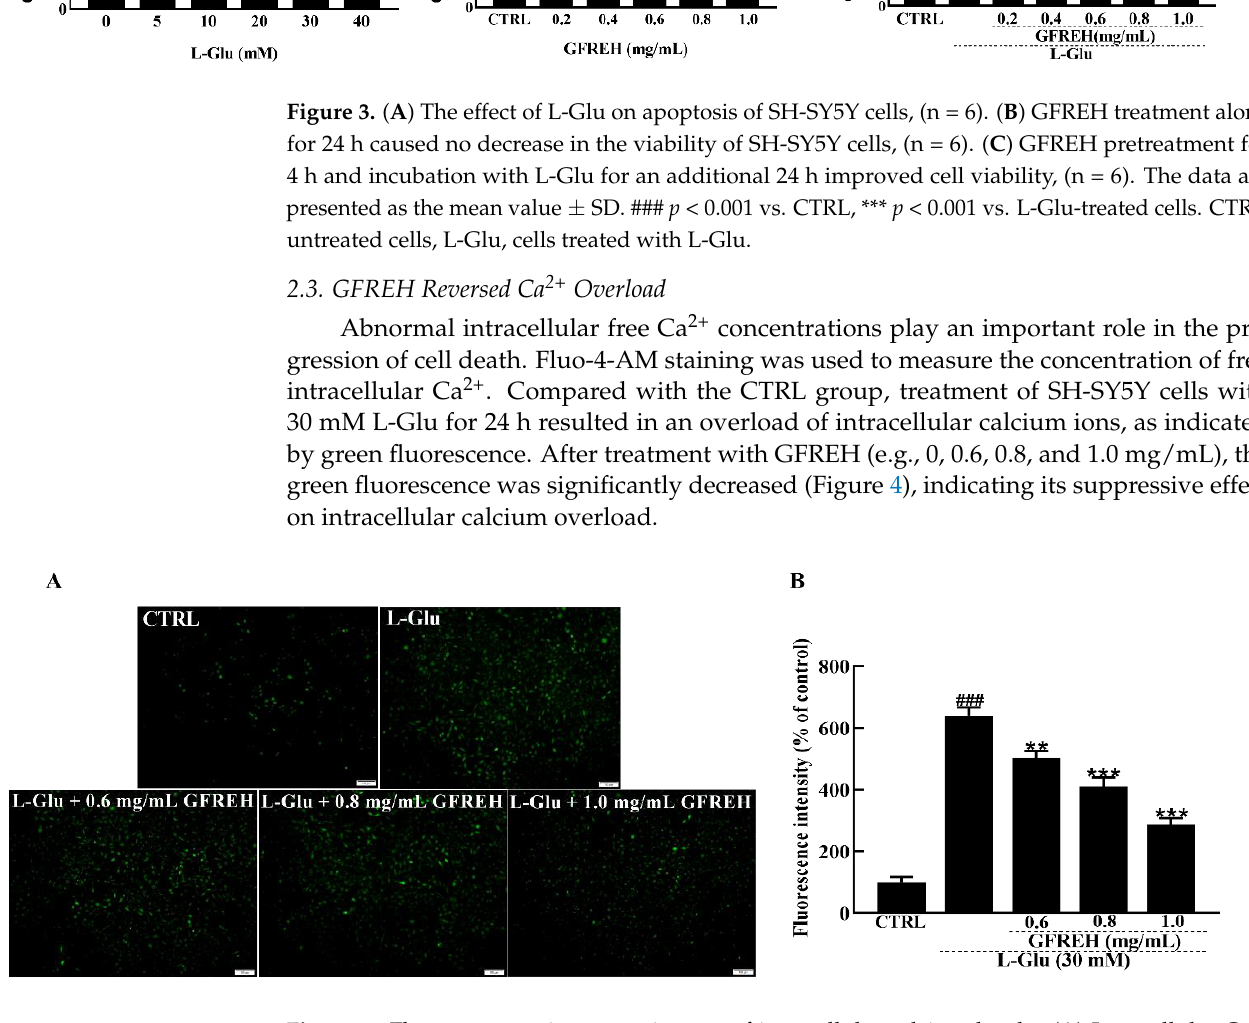
Figure 4. Fluorescence microscopy images of intracellular calcium levels. ( A ) Intracellular Ca 2+ overload caused by L-Glu was reversed by GFREH pretreatment, as detected by Fluo-4-AM stain- ing. The scale bar is 100 μm. ( B ) Fluorescence quantification by ImageJ software (version: 1.51), (n = 3). The data are presented as the mean value ± SD. ### p < 0.001 vs. CTRL, ** p < 0.01, *** p < 0.001 vs. L-Glu-treated cells.